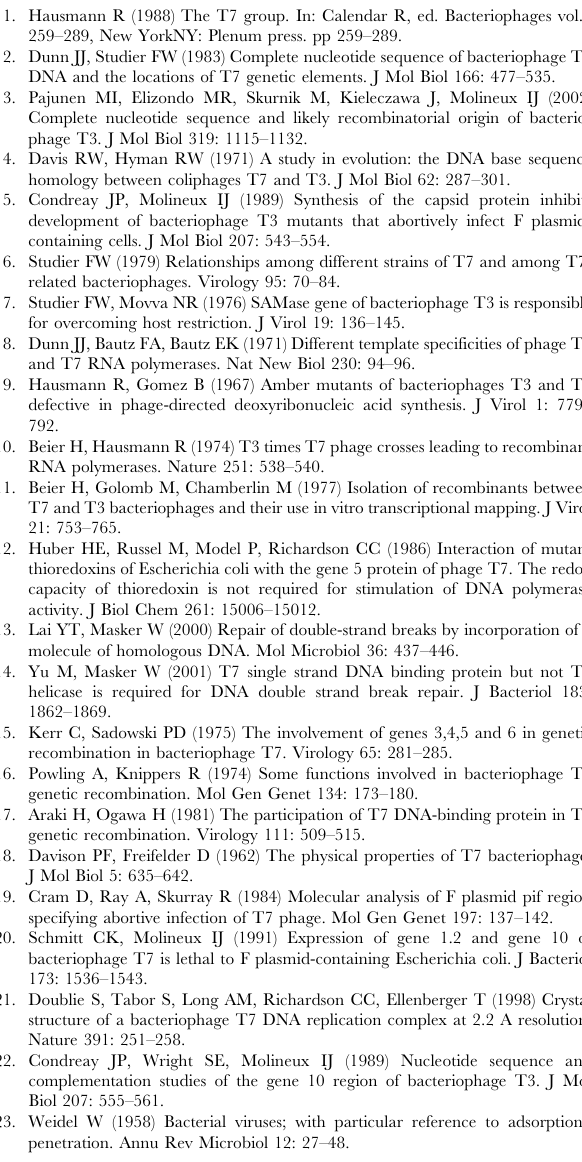
Table S5 Sequenced positions of phage T3/7 and changes relative to T3L. The numberings of nucleotides (2 nd column), genes, promoters (A, w ), terminators (T), and RNase III sites (R) follow those of phage T3L, except that due to the shorter exchanged T7 region, the numbering of T3/7 in column 2 is reduced by 13 compared to T3. For the regions changed to T7, the nucleotide numbering in the T7 genome are indicated in the fourth column, while the multiple base changes are not listed. In the fifth column, a slash indicates the mutation location between the two identities. (DOC) Conceived and designed the experiments: TYL. Performed the experi- ments: TYL YHL PWT SFC YTL TSC. Analyzed the data: TYL. Wrote the paper: